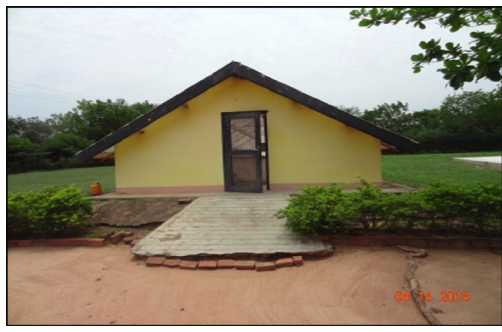
Figure 1: Pictorial representation of the concrete solar dryer Table 1: Major volatile compounds detected in pretreated sliced fresh yellow ginger rhizome.